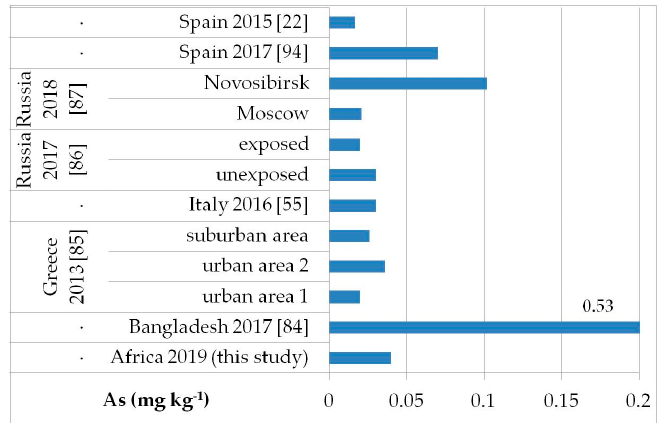
Figure 2. Comparison of the As concentrations in children’s hair (as geometric mean; mg kg − 1 ) found in our study and other biomonitoring studies. Int. J. Environ. Res. Public Health 2020 , 17 , x